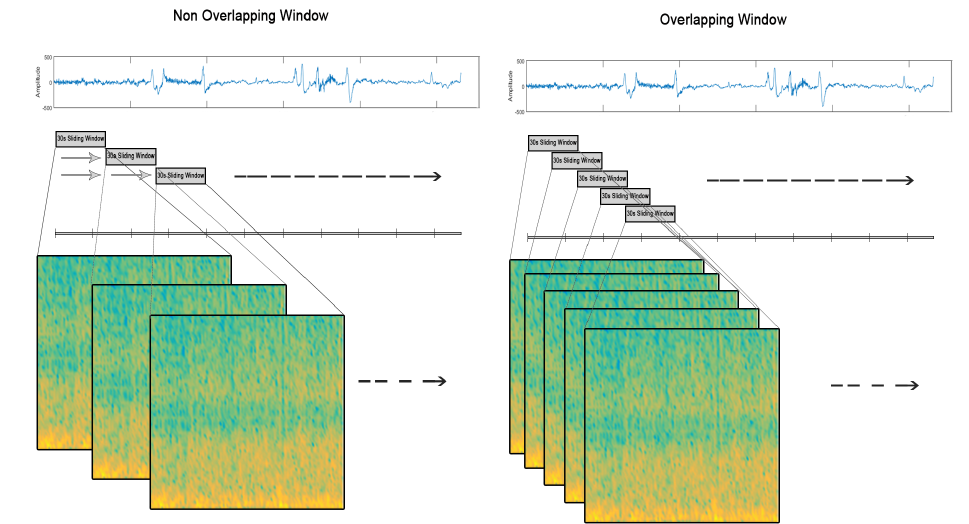
Figure 3. Non-overlapping/overlapping window